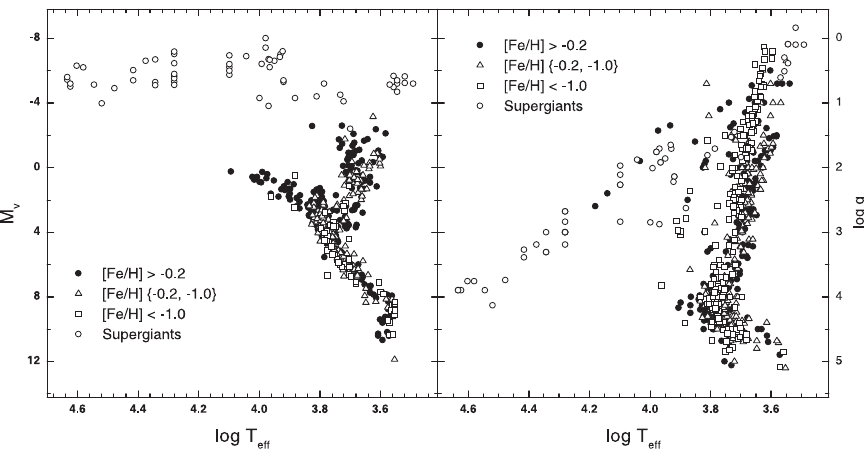
Fig. 2. HR diagram and log g , log T e diagram for the sample